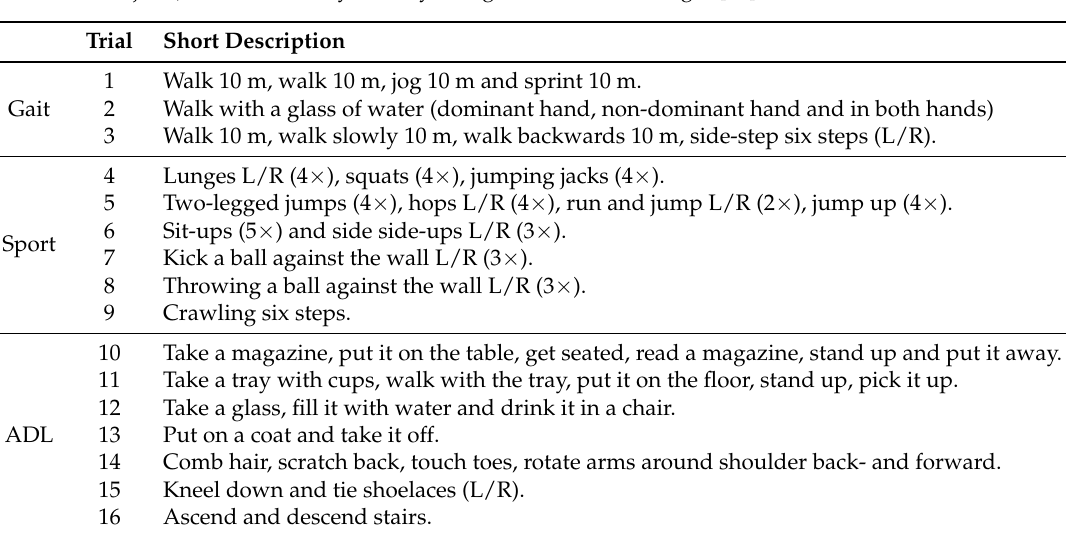
Table 1. A description of trials in the experimental protocol (each trial was performed three times by all six subjects). ADL = Activity of daily living, L = left and R = right [24].